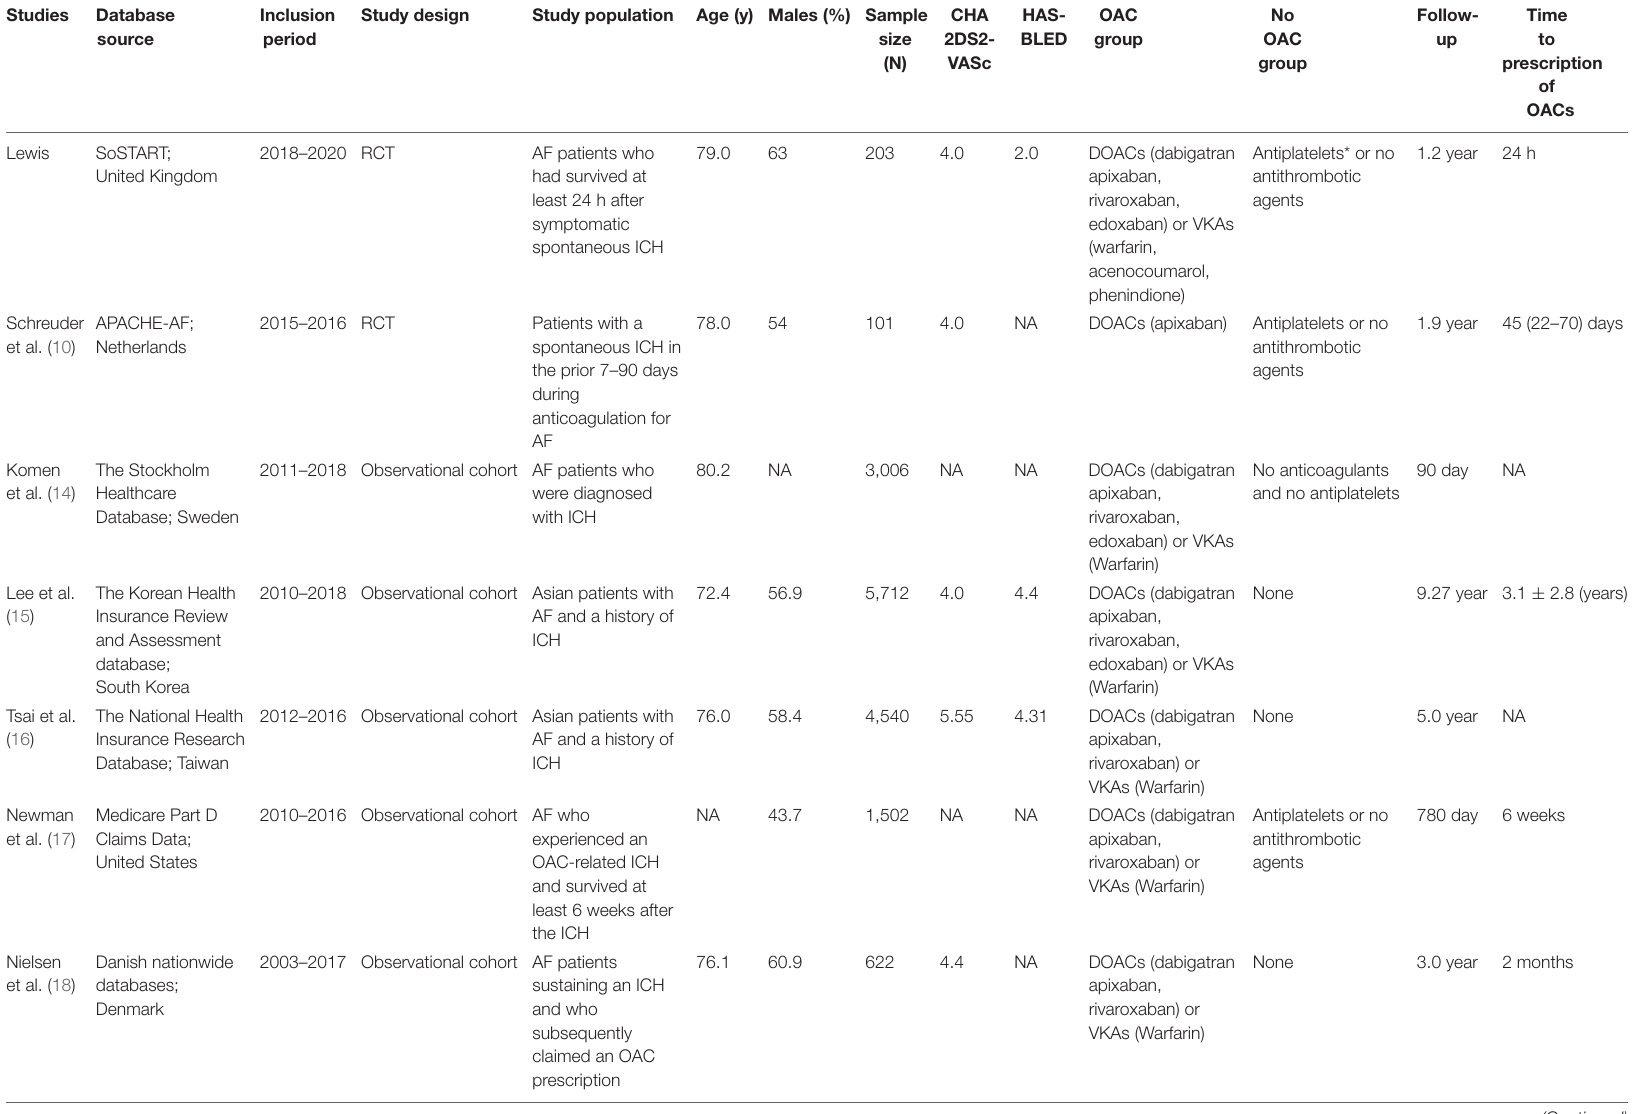
TABLE 1 | Baseline characteristics of the included studies in this